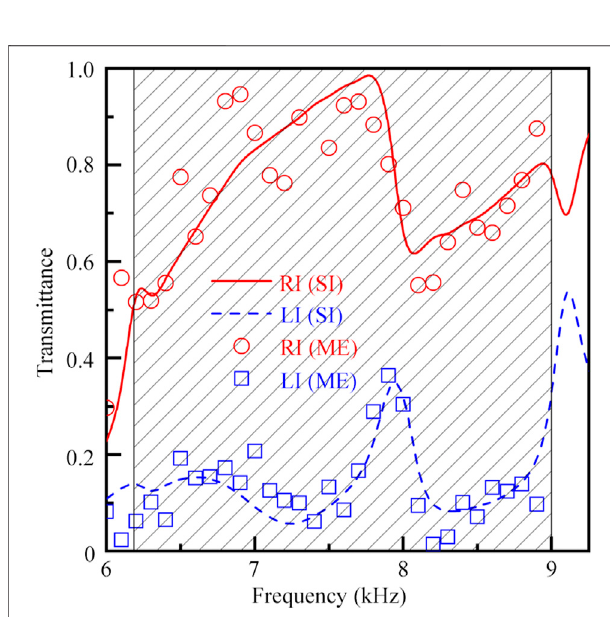
FIGURE 6 | Simulated and measured transmittance spectra created by the UAI lens under the incidence of the zero-order wave for RI and LI.